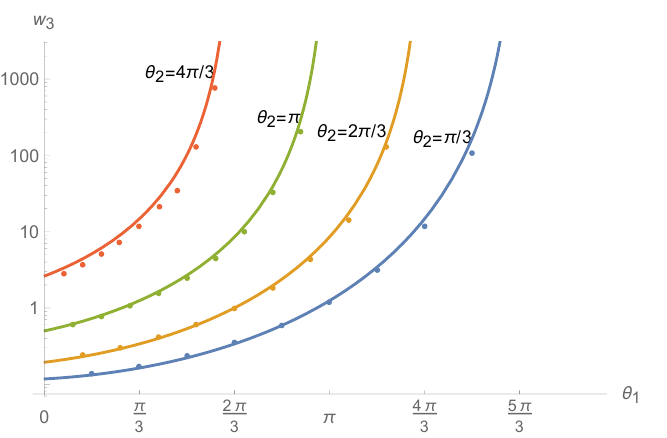
Figure 2 . w 3 as a function of θ 1 with different fixed θ 2 . The dots represent the data obtained by numerically solving the integral equations with λ = 1000